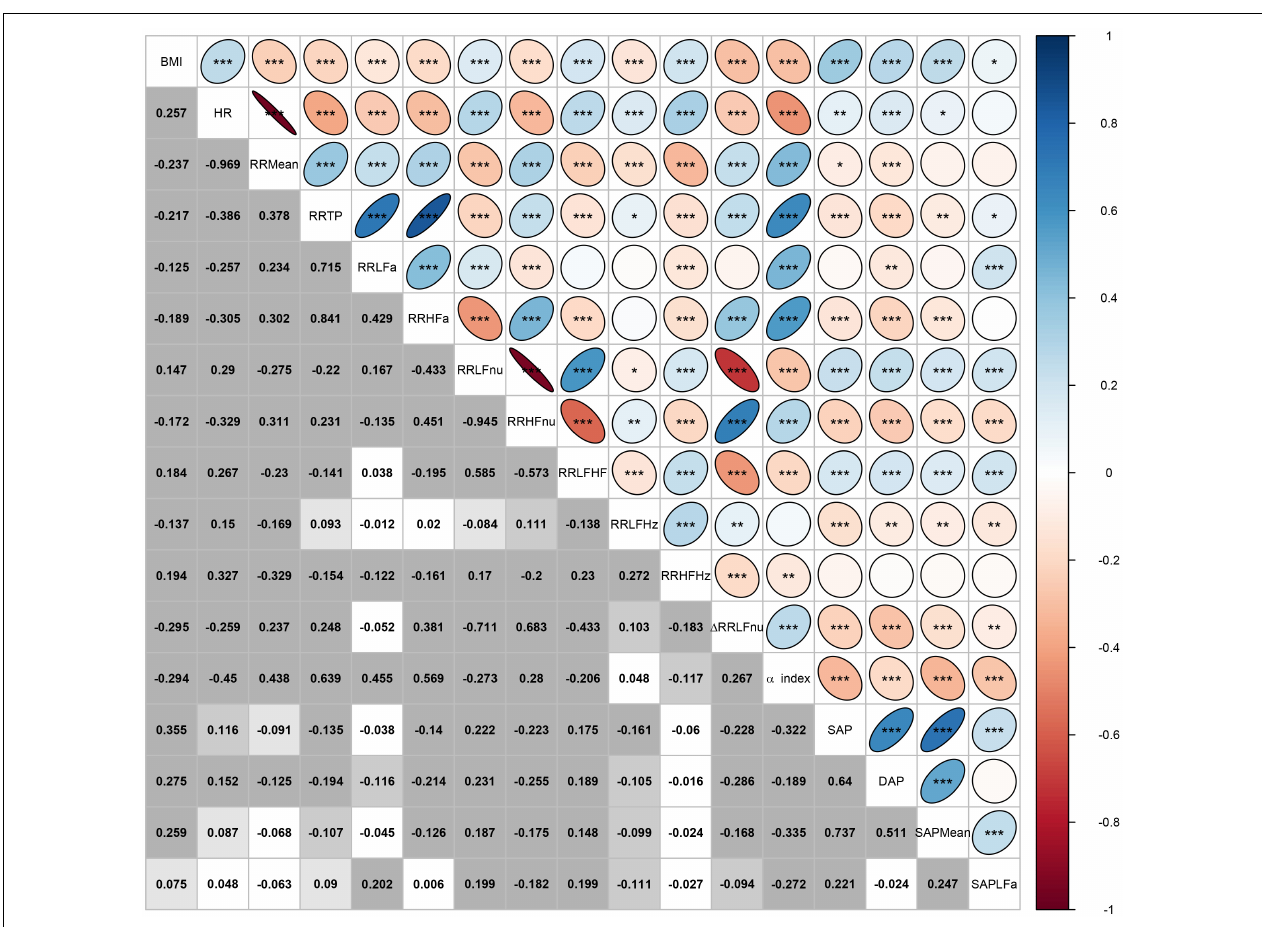
FIGURE 3 | Correlation plot of BMI and the ANS proxies computed over the whole set of subjects. In the lower triangular part of the matrix, displayed values are the Pearson correlation coefficients r computed for every pair of variables (cid:0) X j , X t (cid:1) , j , t = 1 ,..., 17, and j (cid:54)= t . In each cell, background gray shades denote the empirical significance level of each test for null correlation, i.e., H 0 : ρ (cid:0) X j , X t (cid:1) = 0 vs. H 1 : ρ (cid:0) X j , X t (cid:1) (cid:54)= 0: